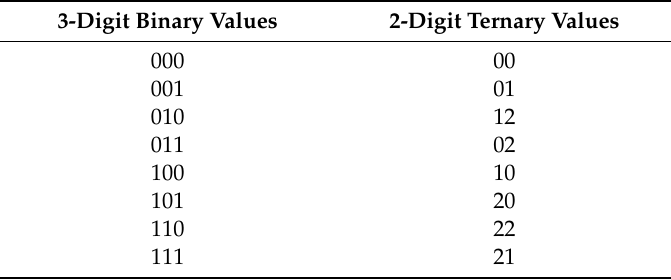
Table 3. Three-bit unit binary-to-ternary data